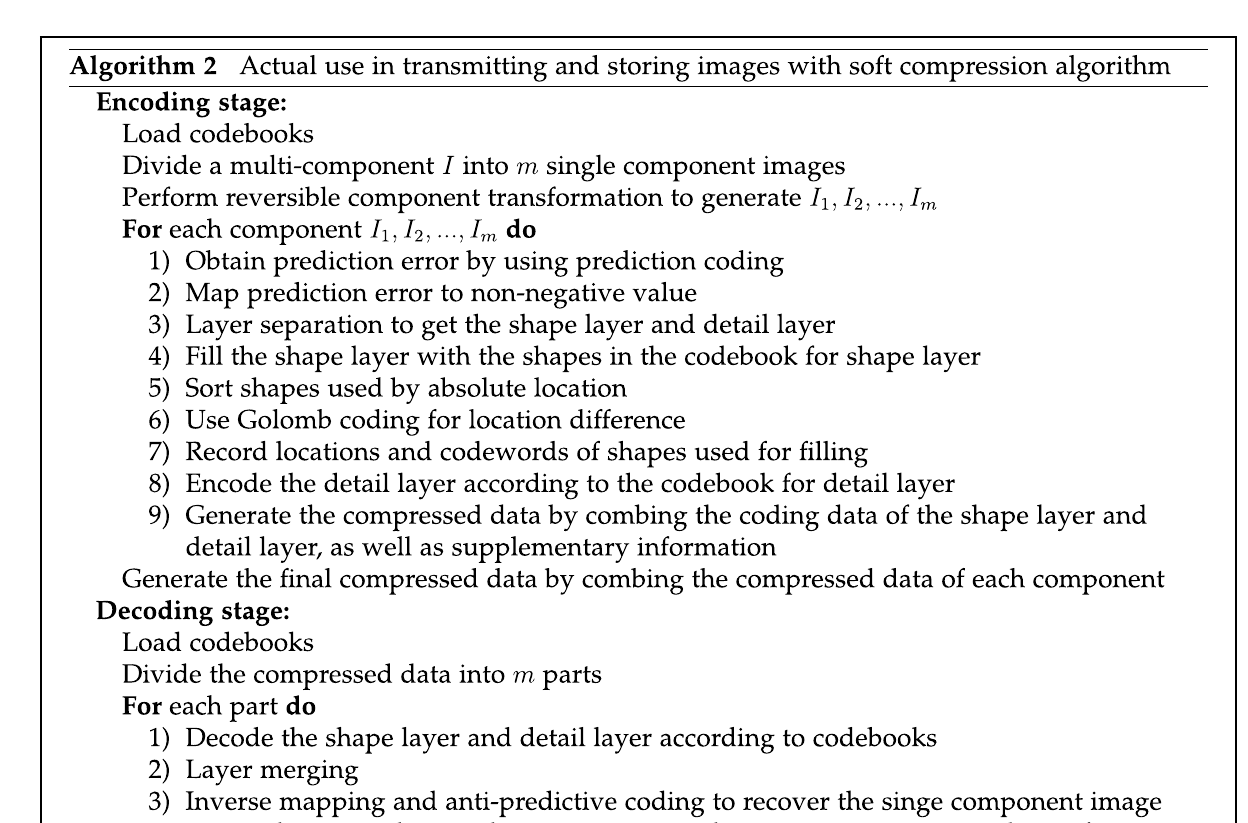
Figure 6. Acquiring codebooks for images with soft compression algorithm. It consists of prediction coding, mapping, layer separation, searching and assigning codewords.